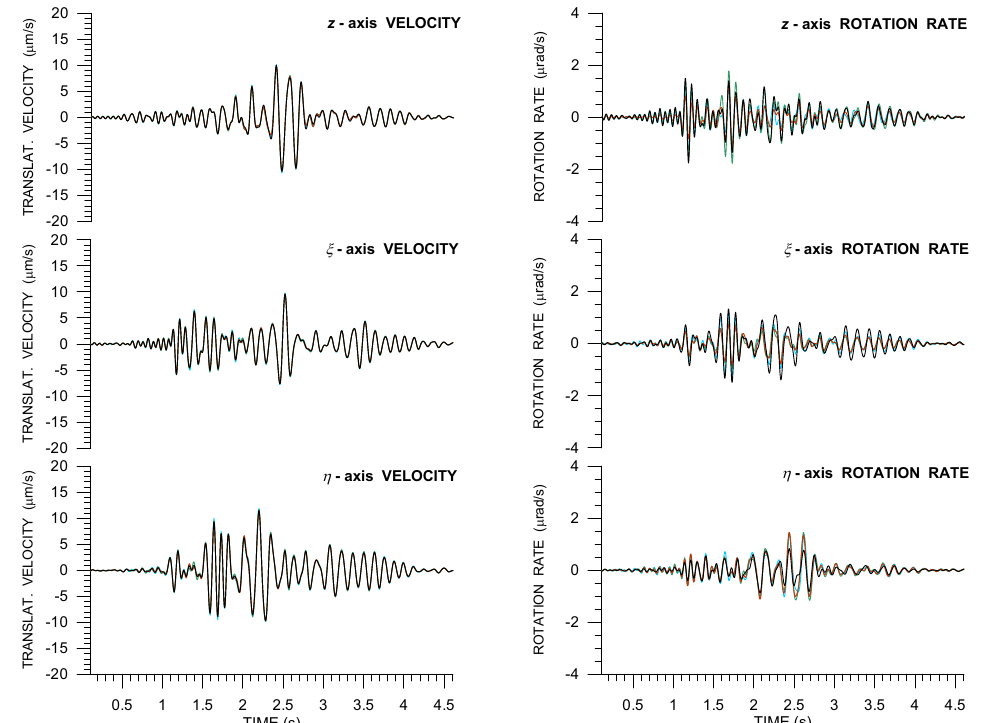
Figure 9. A small-size explosion (Expl4 in Table A1) at a distance of 676 m from R10 as recorded by four 6C Rotaphone-CY instruments (R8—red, R10—black, R11—light blue, and R13—green) in the active phase of the GOF experiment. Horizontal components are rotated into radial and transverse directions according to the geometrical azimuth of 293.0 ◦